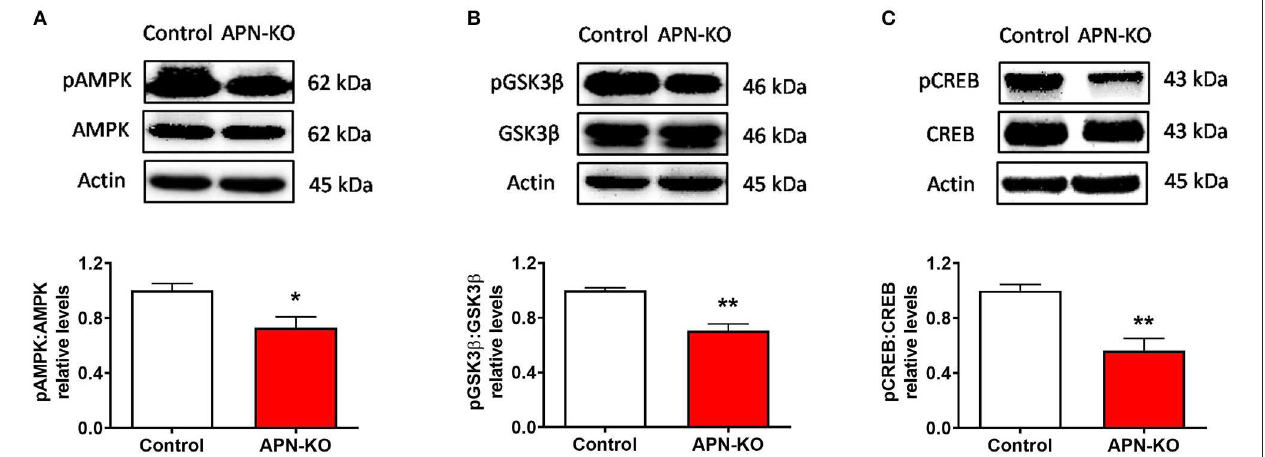
FIGURE 5 | Altered phosphorylation of downstream signaling molecules in APN-KO mice. Representative immunoblots showing (A) pAMPK/AMPK relative densities (B) pGSK3 β /GSK3 β relative densities and (C) pCREB/CREB relative densities, in total hippocampal lysate. Forty micrograms of protein were loaded per lane. Bars represent mean ± SEM; * p < 0.05, ** p < 0.01; n = 4 mice per group.